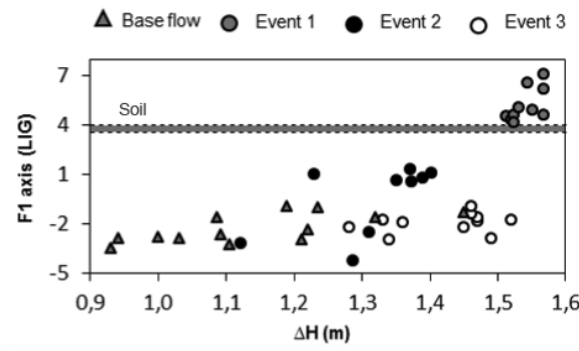
Figure 5. Evolution of LIG distribution evidenced by PCA analysis as a function of (cid:49)